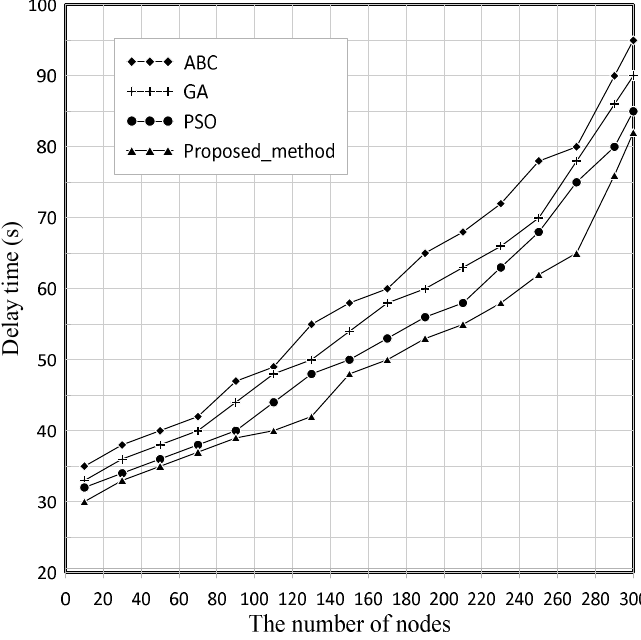
Figure 13. Comparison of ABC, GA, PSO, and the proposed method in delay time .